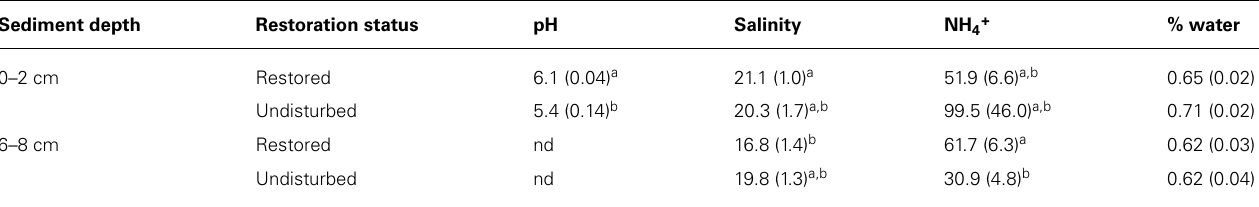
Table 1 | Mean ( ± SE) salinity, pH, ammonium, and % water in porewater of sediments from 0 to 2 cm and 6 to 8 cm from samples collected in restored and undisturbed